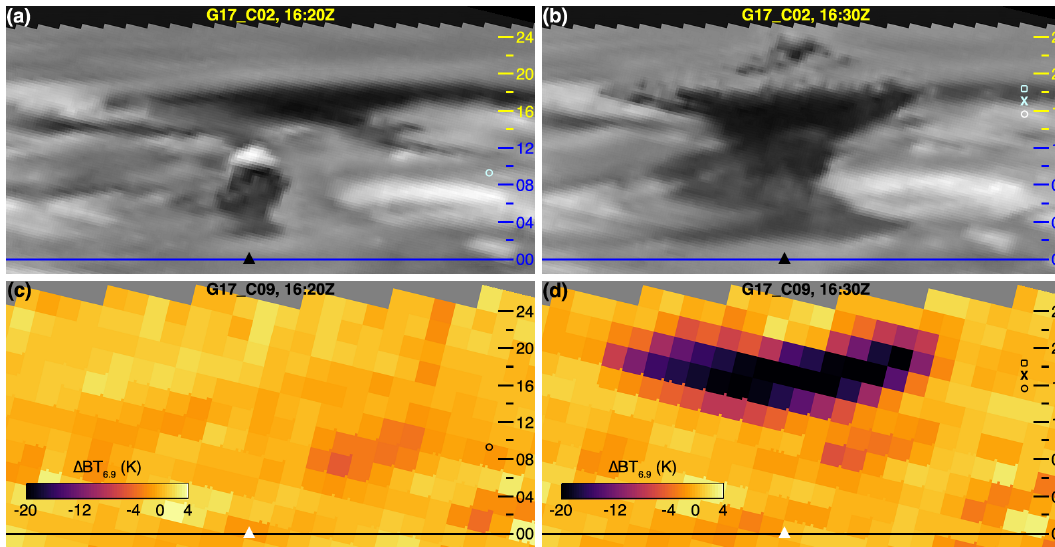
Figure 8. The eruption plume on 10 April 2021 at (a, c) 16:20UTC and (b, d) 16:30UTC in GOES-17 imagery: (a, b) channel 2 and (c, d) channel 9 running difference, with elevation markings as in Fig.